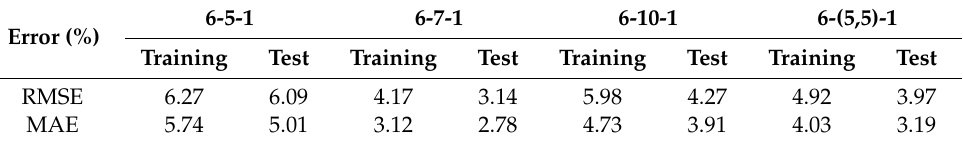
Table 2. Comparison between different network structures.